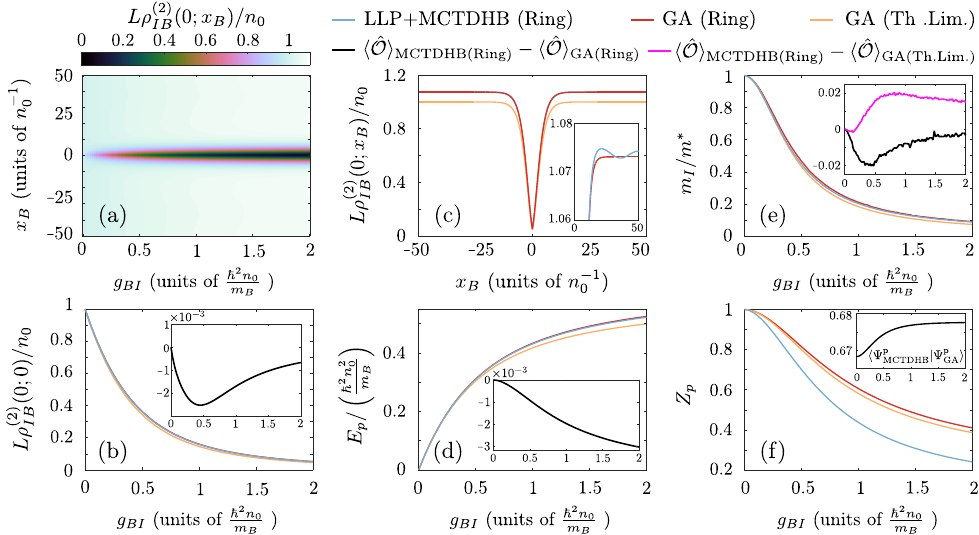
Figure 3. Comparison of the Bose polaron characteristics between the GA and the correlated MCTDHB framework. ( a ) Bath-impurity correlations, ρ strength, g BI , within MCTDHB. ( b ) Bath-impurity correlations at coincidence, ρ g BI and for all employed approaches (see legend). ( c ) Comparison of the correlation profile ρ within the MCTDHB and the GA for g BI = 2¯ h 2 n 0 / m B . The inset of ( c ) provides a magnification ( 2 ) ( 0; x ) , showing the behavior of the system away from the impurity. Comparison of ( d ) the of ρ B IB polaron energy, E p , ( e ) the inverse effective mass, m I / m ∗ and ( f ) the polaron residue among the different approaches and for varying g BI . To elucidate the comparison between GA and MCTDHB, the insets of ( b , d , e ) provide the difference of the corresponding observables between the distinct approaches (see legend). The inset of ( f ) indicates the many-body overlap between the MCTDHB and the GA many-body states for varying g BI . In all cases, m I = m B , p I = 0 and g BB = 0.1¯ h 2 n 0 / m B . The relevant ring confined setups are characterized by N B = 100 and L = 100 n − 1